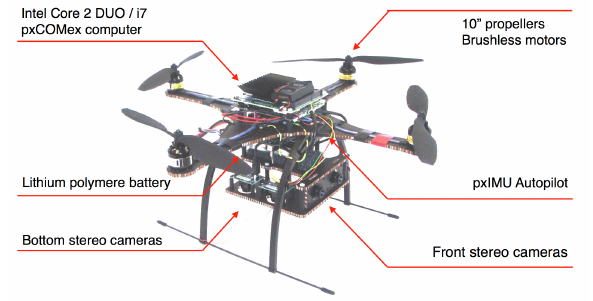
Figure 4: Overview of all hardware components.